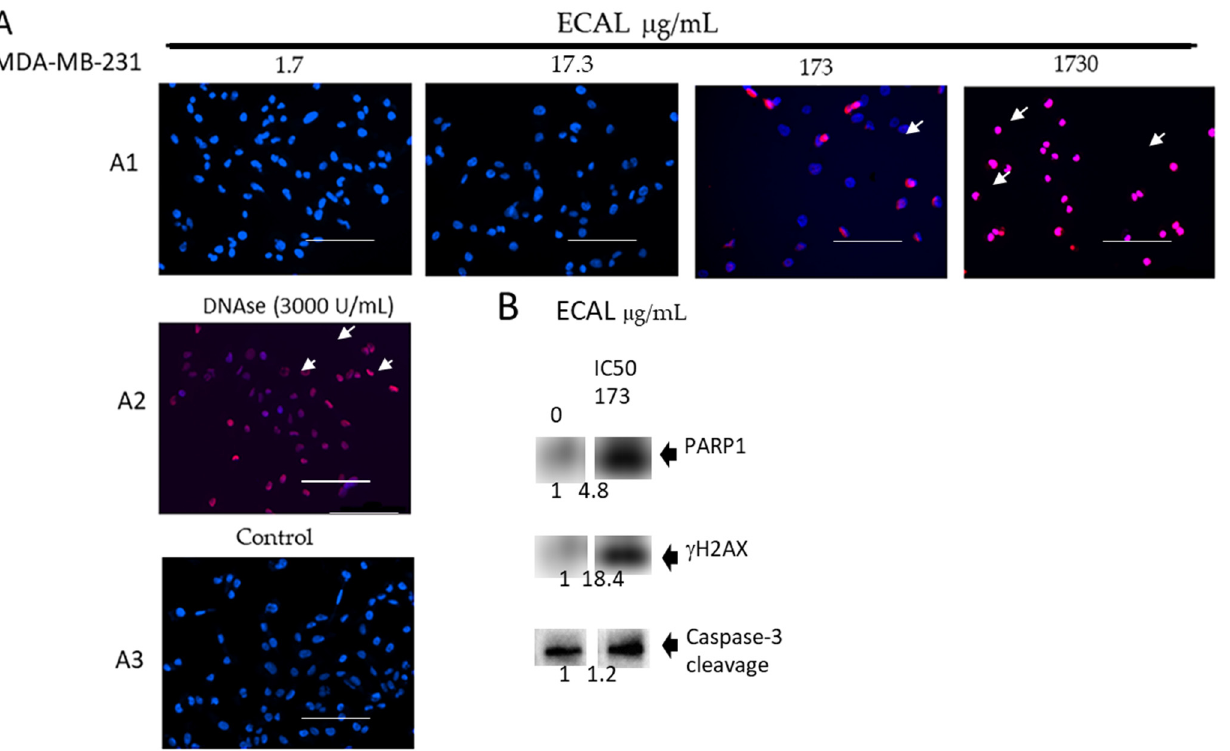
Figure 3. DNA damage induced by the hydroethanolic extract of C. album leaves (ECAL). ( A ) TUNEL staining for apoptosis in MDA-MB-231 cells incubated for 24 h. ( A1 ) with the increasing concentrations of ECAL (1.7–1730 µ g/mL); ( A2 ) with DNAse (3000 U/mL); ( A3 ) without treatment (control). Blue nuclear stain and green TUNEL stain. TUNEL-positive apoptotic cells (arrows) are those in which the green and blue colocalize to the same cell. Scale bar = 100 µ M; ( B ) immunoblot images of proteins γ H2AX, PARP1 and Caspase-3 cleaved (histone H3, as the internal control) wherein the fold changes have been presented below each panel.